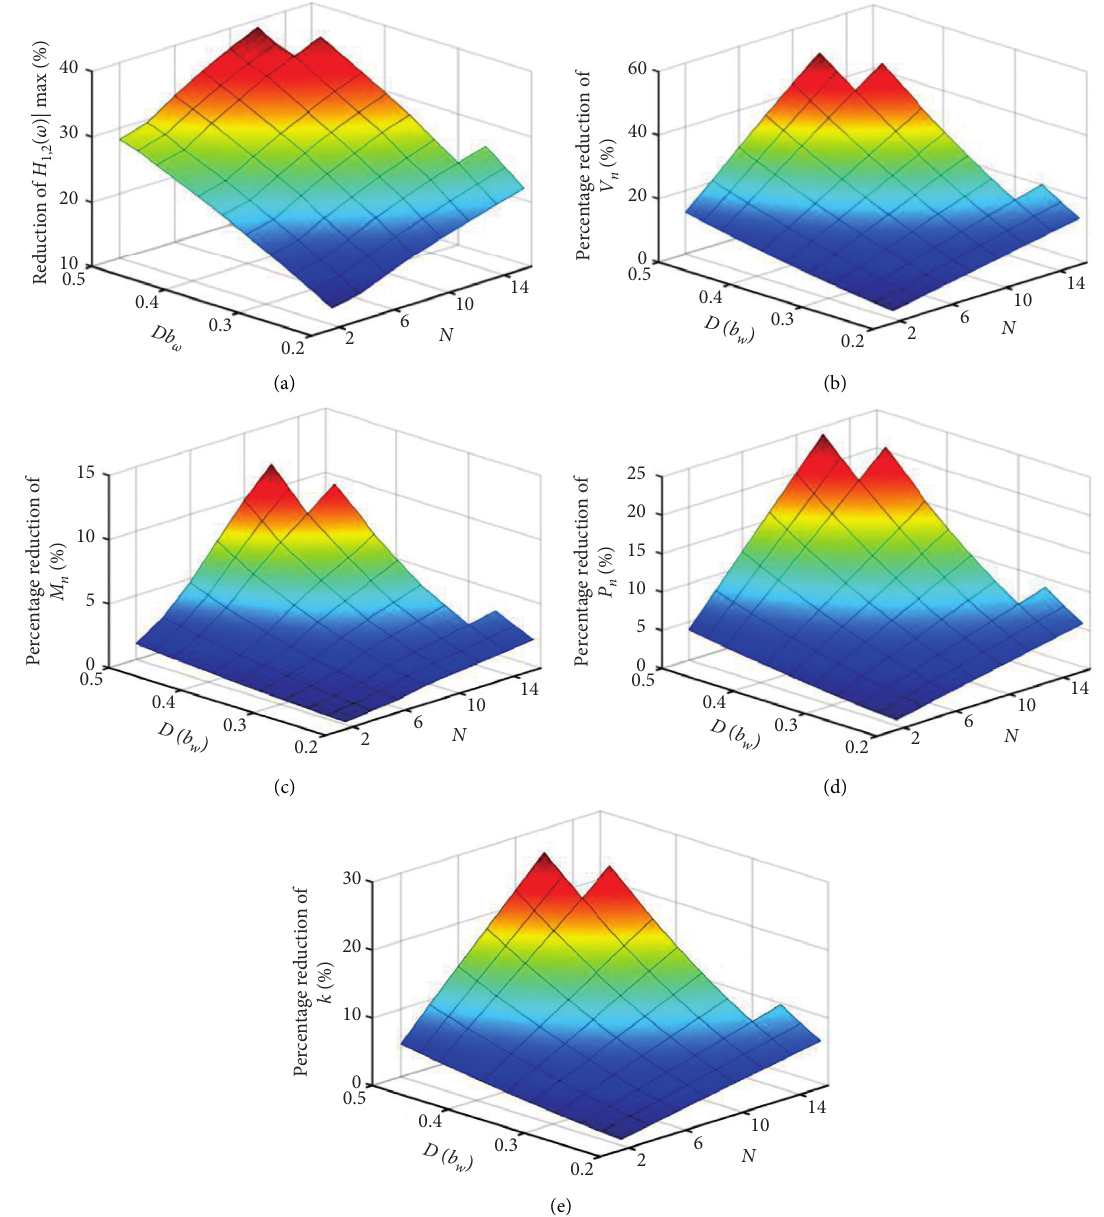
Figure 11: Surface plot of percentage reduction in performance objectives: (a) maximum of displacement/acceleration transfer functions, (b) nominal shear strength, (c) nominal flexural strength under balanced axial interaction, (d) nominal axial strength, and (e) lateral